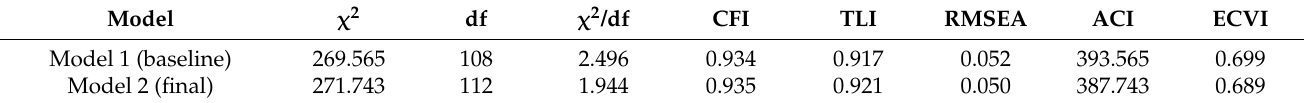
Table 3. Model Fit of Measurement Models.